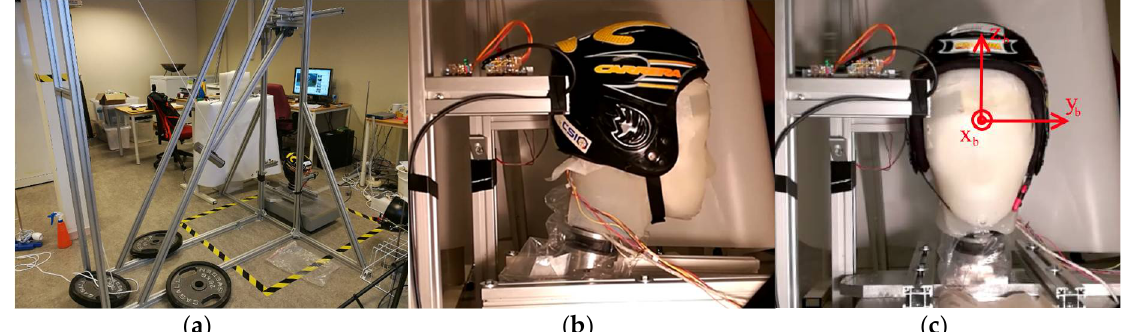
Figure 3. Pilot tests. ( a ) Impact pendulum and experimental setup; ( b ) back impact on surrogate IHHeadS_1; ( c ) right side impact on surrogate IHHeadS_1.